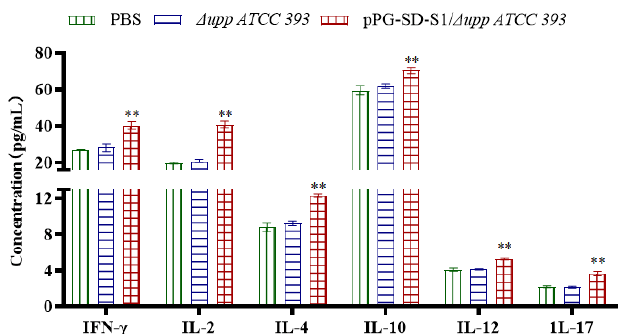
Figure 6. Determination of cytokine levels in immunized mice. Cytokine levels, including IFN- γ , IL-2, IL-4, IL-10, IL-12 and IL-17, were detected in the sera of mice on the 42nd day after the primary immunization. The concentrations of cytokines were calculated according to the standard curve. Bars represent mean ± standard error in each group (** p < 0.01 compared to the control groups: PBS and Δ upp ATCC 393 ).